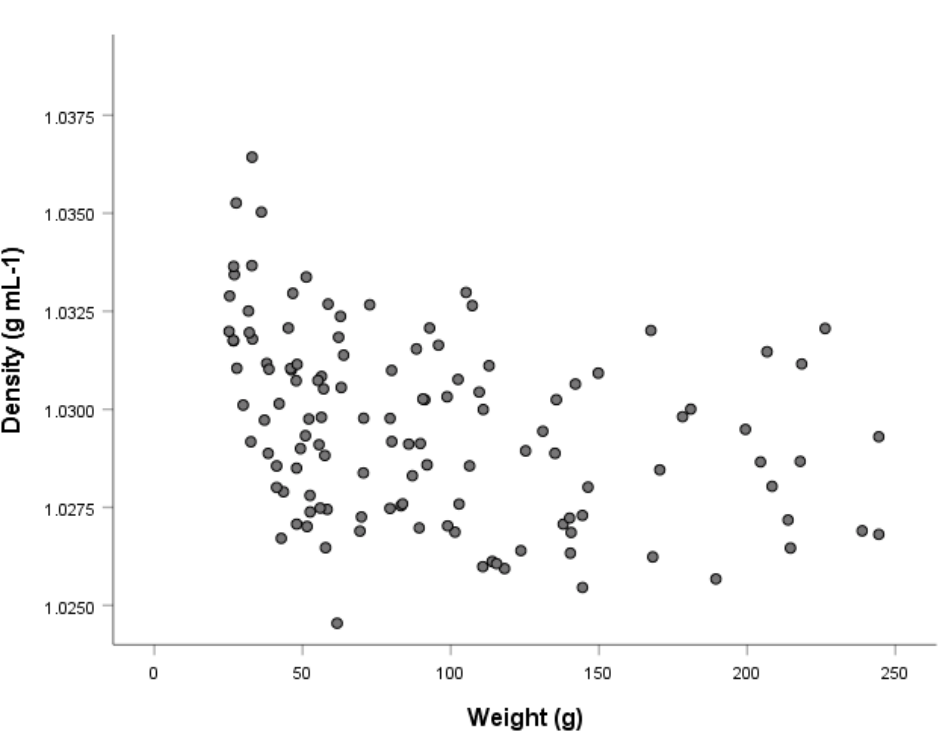
Figure 8. A scatterplot between lumpfish body density and weight ( n = 123). Location D was excluded from the analysis.